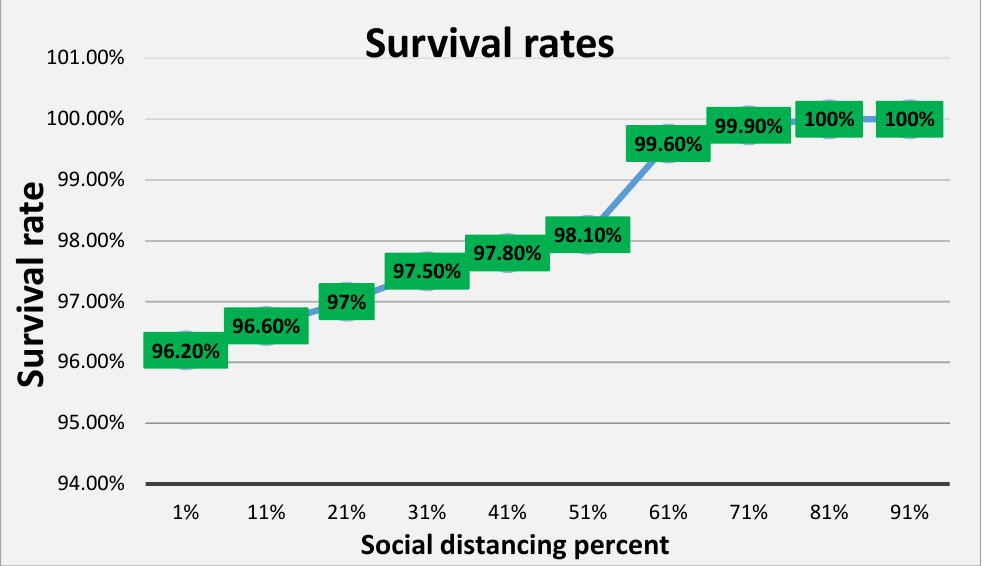
Figure 19. Recovery rate (recovered/total population) versus percentage of social distancing.